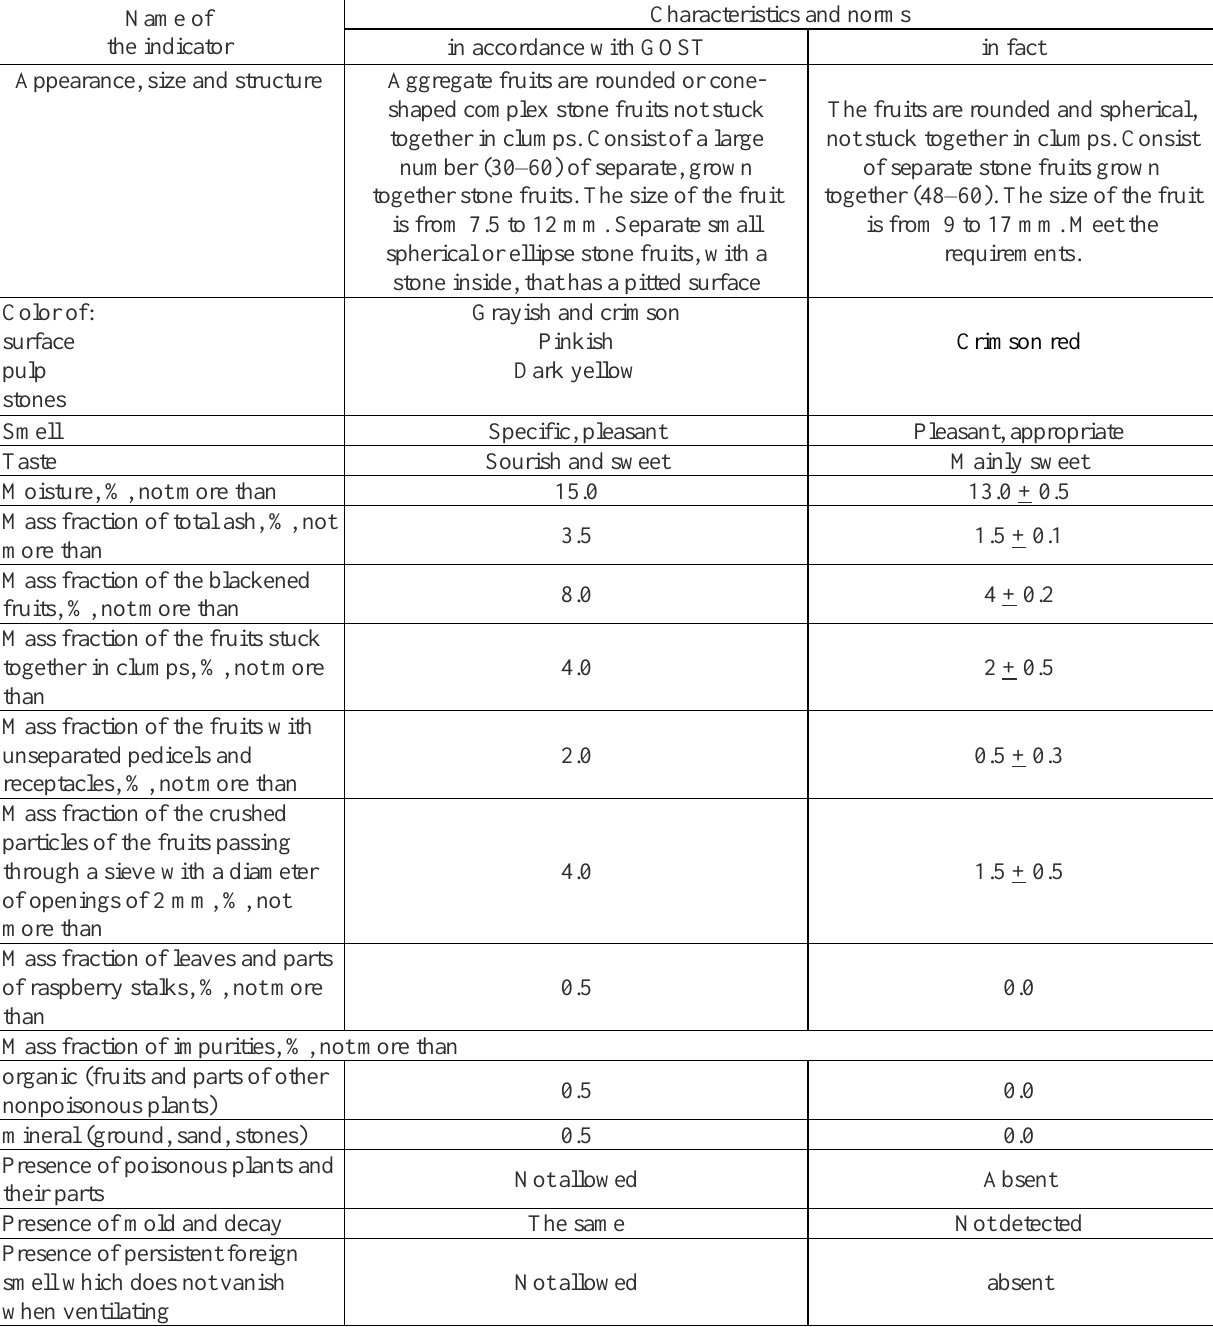
Table 5. Indicators of quality of fruits of Rubus idaeus (raspberry , the grade “Nagrada”), n =